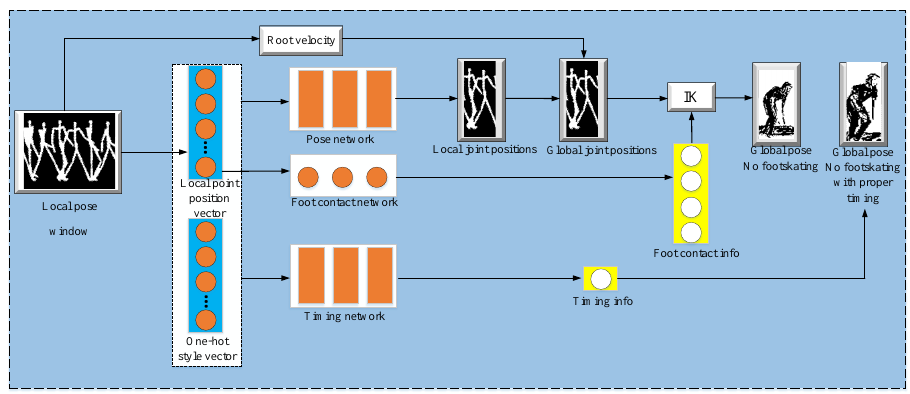
Figure 3. Real-time motion style transfer from motion-captured datasets.